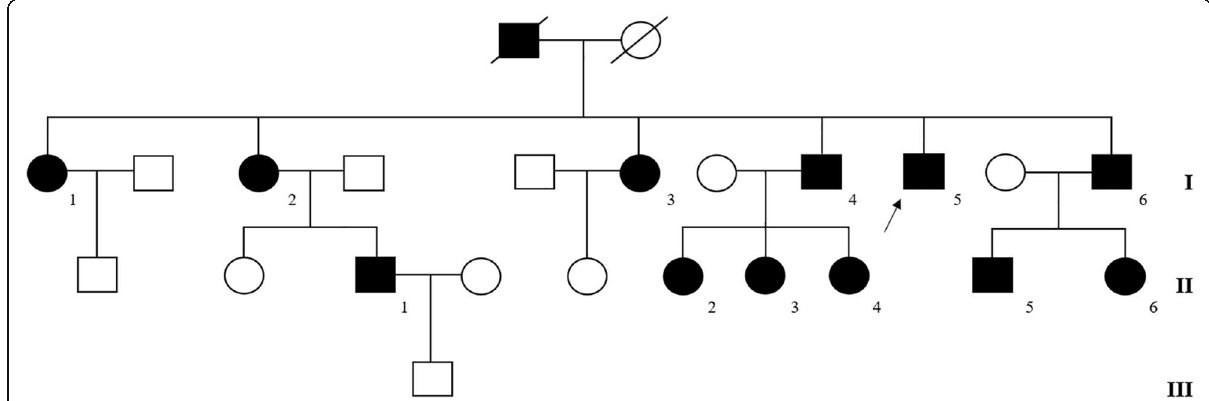
Fig. 1 FHM1 pedigree chart of the family. Circles represent the females and squares represent males. Black squares and circles indicate affected males and females, respectively. White squares or circles represent members without FHM. The diagonal lines represent deceased subjects. The arrow indicates the index